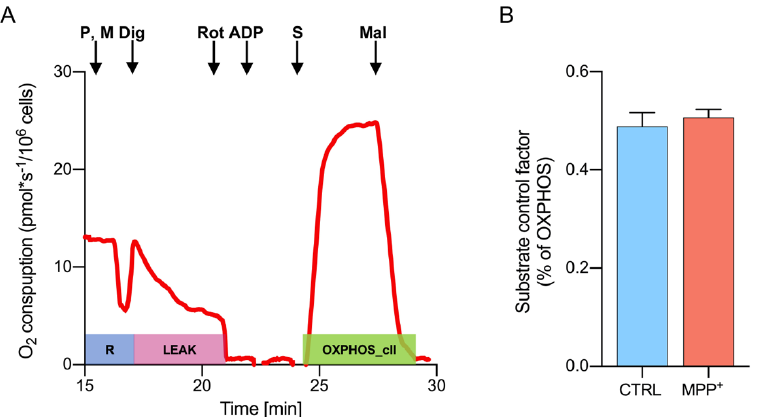
Figure 5. Specific contribution of complex I and complex II to different respiratory states. ( A ) Quantitative analysis of the oxygen consumption rate and the relative FCR of OXPHOS state sustained by complex I. Data were obtained by measuring OXPHOS respiration in the absence of succinate. ( B ) Rate of oxygen flux OXPHOS respiration sustained by complex I coupled with the ADP phosphorylation. ( C ) Quantitative analysis of the oxygen consumption rate and the relative FCR of ETS sustained by complex II. Data were obtained by measuring ETS after inhibition of complex I activity with rotenone. Data are shown as percentage of the reference state and expressed as means with standard deviation;